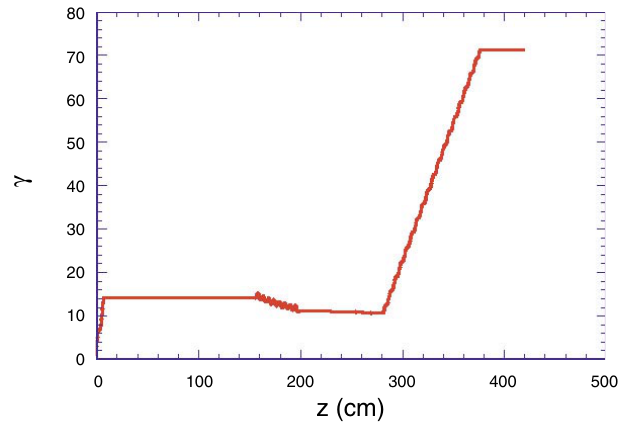
FIG. 4. (Color) Evolution of the rms bunch length for 1 nC beam in the ORION photoinjector, velocity-bunching case, from PARMELA